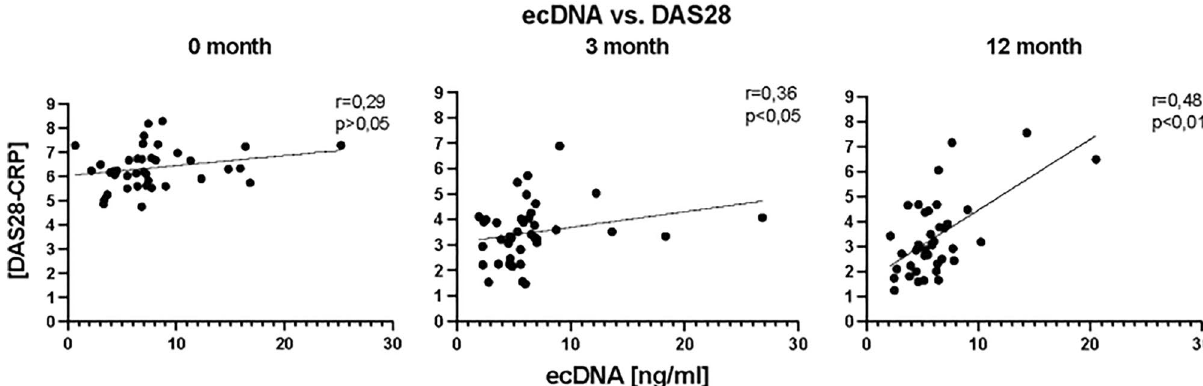
Figure 5. Correlations between concentration of total extracellular DNA (ecDNA) in plasma and disease activity score evaluating 28 joints (DAS28) in specified time points.